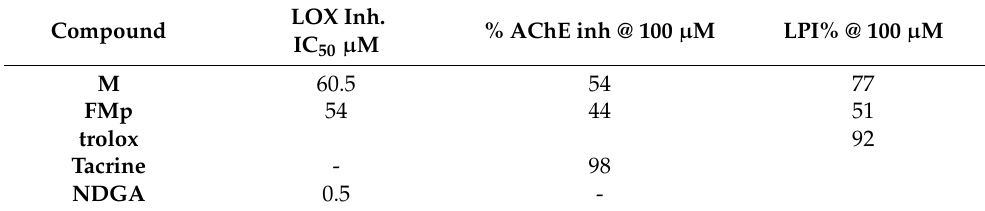
Table 1. In vitro inhibition of soybean lipoxygenase (IC 50 µ M), in vitro inhibition of acetyl- cholinesterase (IC 50 µ M or AChE Inh. %) and lipid peroxidation inhibition (LPI% at 100 µ M). LOX Inh. % AChE inh @ 100 µ M LPI% @ 100 µ M Compound IC 50 µ M M 60.5 54 77 FMp 54 44 51 trolox 92 Tacrine - 98 NDGA